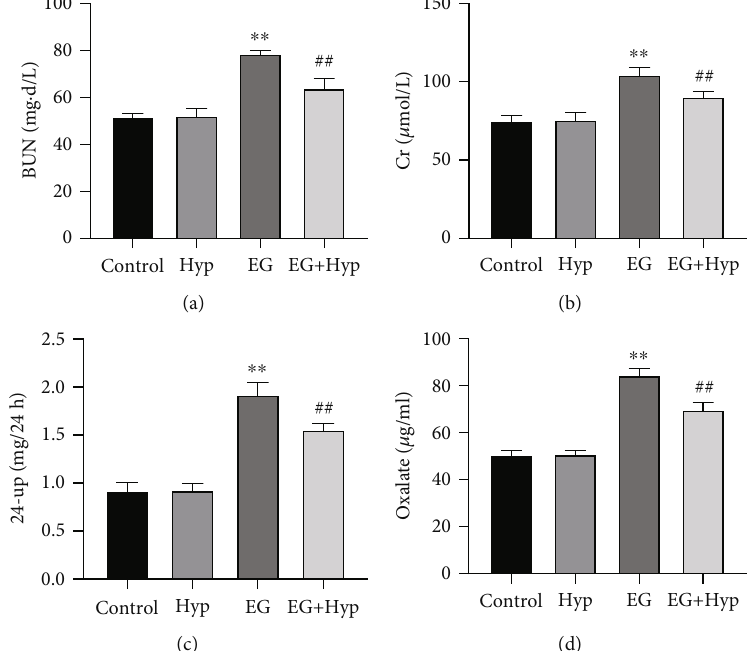
Figure 2: E ff ect of hyperoside on indicators relevant to ethylene glycol-induced renal function injury in rats. (a – d) Biochemical detection of the levels of BUN, Cr, and 24-up in the serum and oxalate in the urine of rats, ∗∗ P < 0 : 01 vs. control group and ## P < 0 : 01 vs. EG group. BUN: urea nitrogen; Cr: creatinine; 24-up: 24h urinary